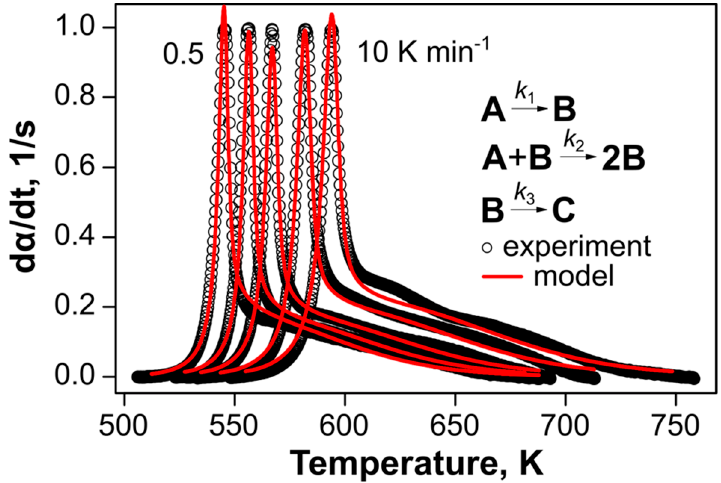
Figure 6. Normalized DSC data for DBT (the empty circles are rarefied experimental points) is fitted by the kinetic model (red curves). From left to right, the datapoints correspond to heating rates of 0.5, 1, 2, 5, and 10 K min − 1 . Table 1. The kinetic parameters calculated using the different approaches for the non-isothermal PDSC data of DBT decomposition.